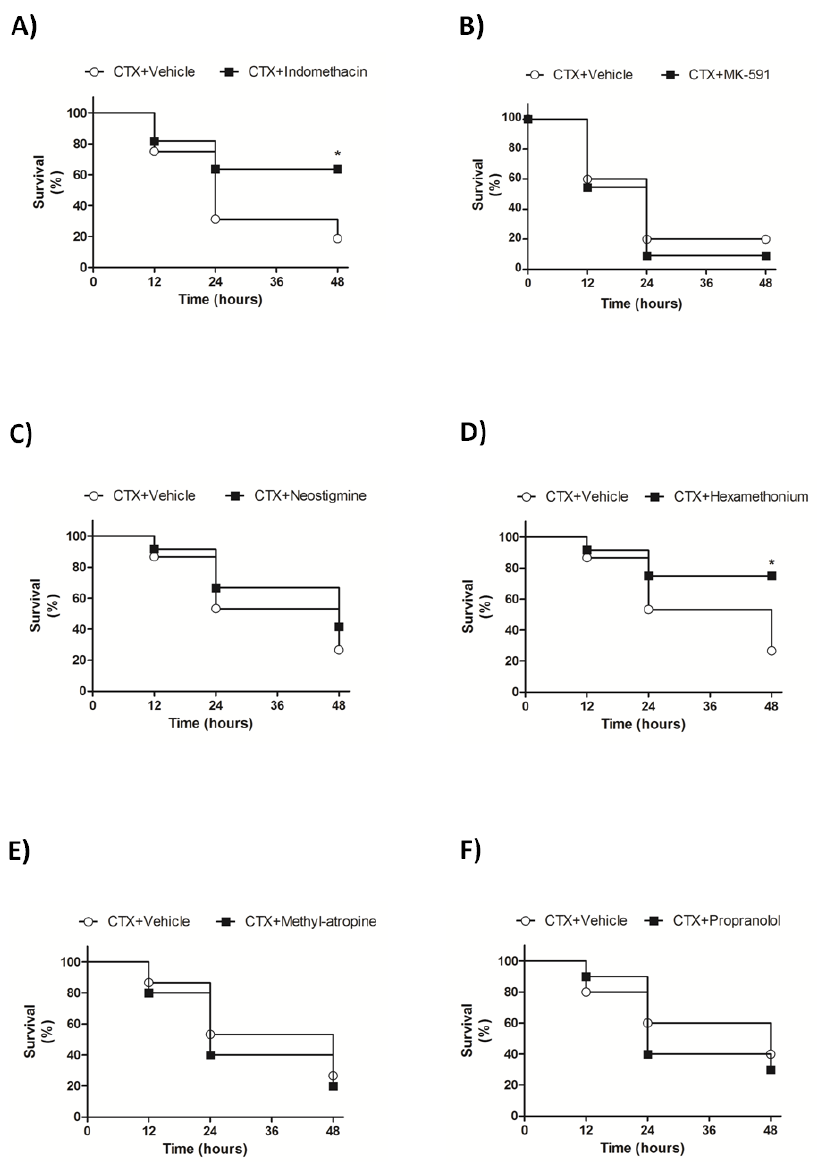
Figure 6. Role of eicosanoids metabolism and peripheral nervous system on survival of CTX-treated mice. Animals were treated with ( A ) Indomethacin (3 mg/Kg i.p.), ( B ) MK-591 (40 mg/Kg i.p.), ( C )